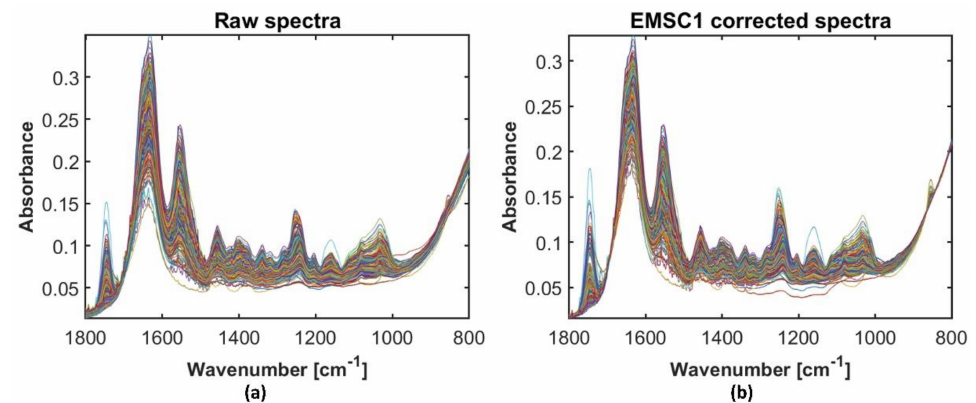
Figure 1. Human dataset 2 samples: ( a ) raw broadband spectra of after removing water spectra by EMSC pre-classification algorithm; ( b ) spectra preprocessed by the weighted EMSC1 (MSC plus linear term) model.